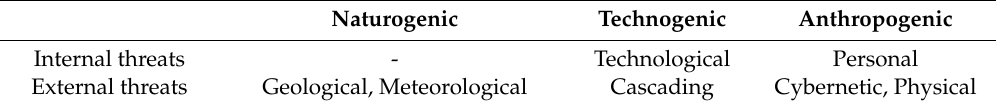
Table 2. Classification of categories of threats to critical infrastructure elements (Rehak et al.